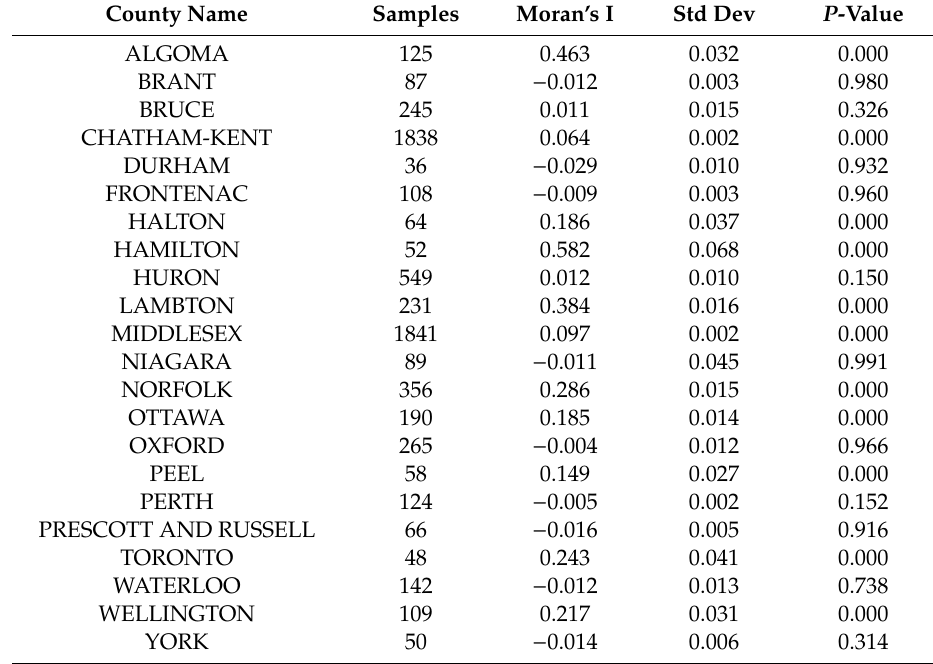
Table 3. The estimated spatial autocorrelation of samples (presence and absence points) in 22 counties based on Moran’s I